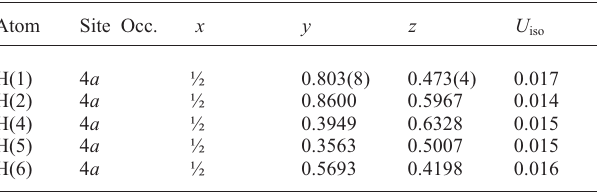
Table 2. Atomic coordinates and displacement parameters (in Å 2 )